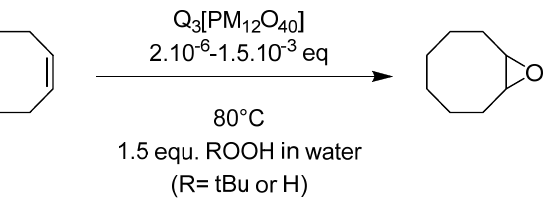
Figure 22. Epoxidation of cyclooctene catalyzed by organic salts of polyoxometalates Q 3 [PM 12 O 40 ]